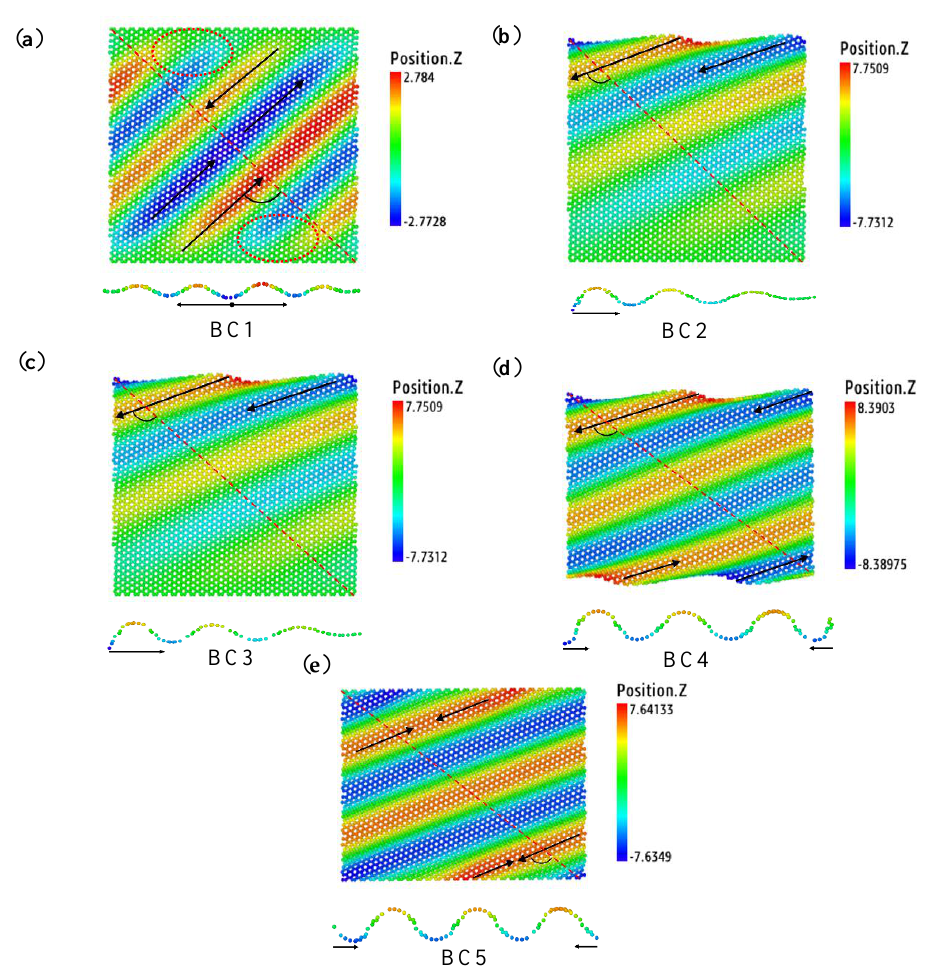
Figure 5. The wrinkle morphologies of graphene sheets under ( a ) BC1, ( b ) BC2, and ( c ) BC3 with a shear displacement of 1 nm applied on the top boundaries, and under ( d ) BC4 and ( e ) BC5 with a shear displacement of 1 nm applied on both the top and bottom boundaries. The shear velocities are 0.1 Å /ps.